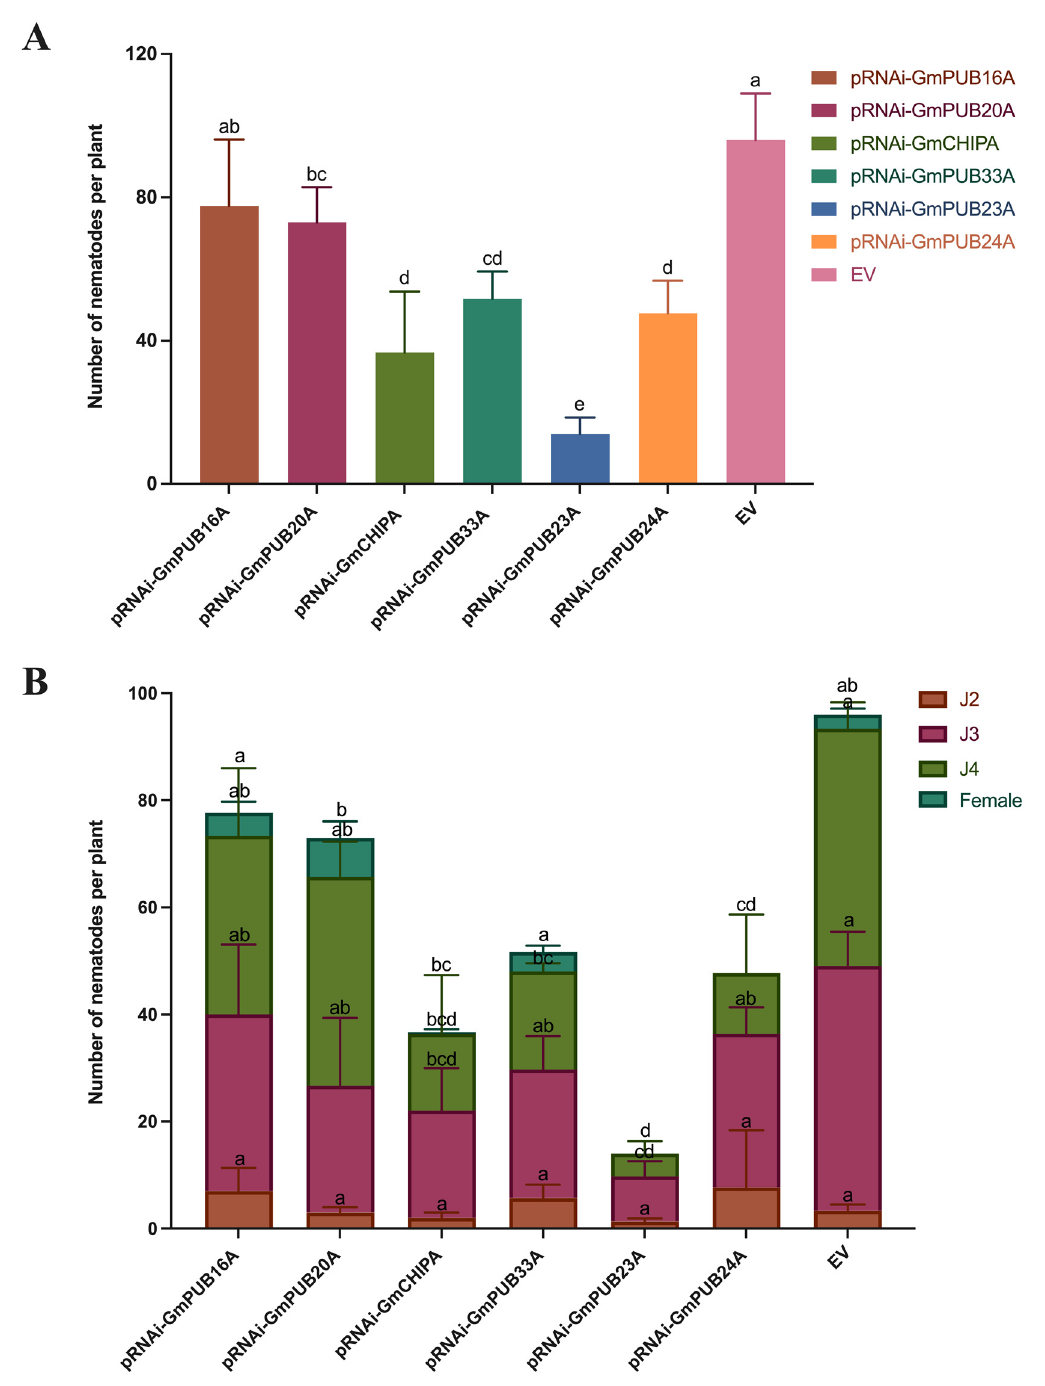
Figure 9. Number of nematodes in the six GmPUBs RNAi hairy roots. Note: ( A ), total number of nematodes per plant, ( B ), number of different stage nematodes per plant. One-way ANOVAs were applied in SPSS to analyze the difference in the number of nematodes in EV and other transgenic hairy roots, and the Holm–Sidak method was used to determine the statistics. Different characters mean significant differences found at p < 0.05